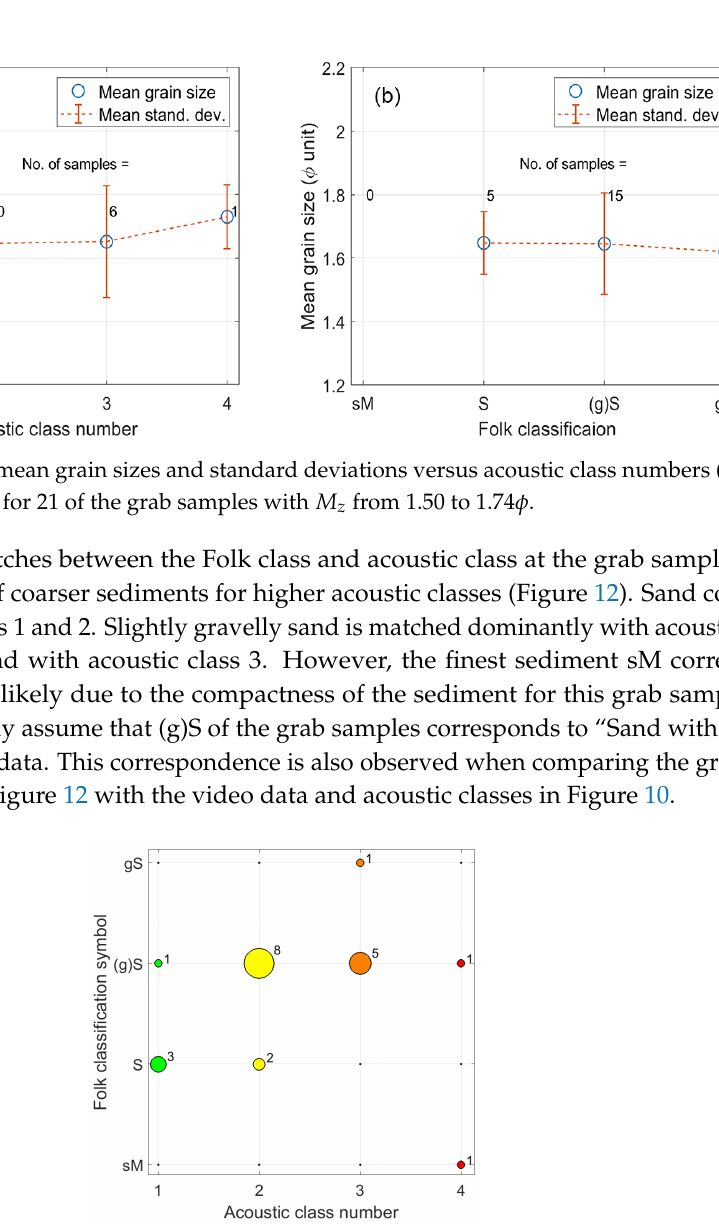
Figure 12. Correlation between sediment type and acoustic class at grab sample locations. Size of dots and numbers indicate number of matches between sediment types and acoustic